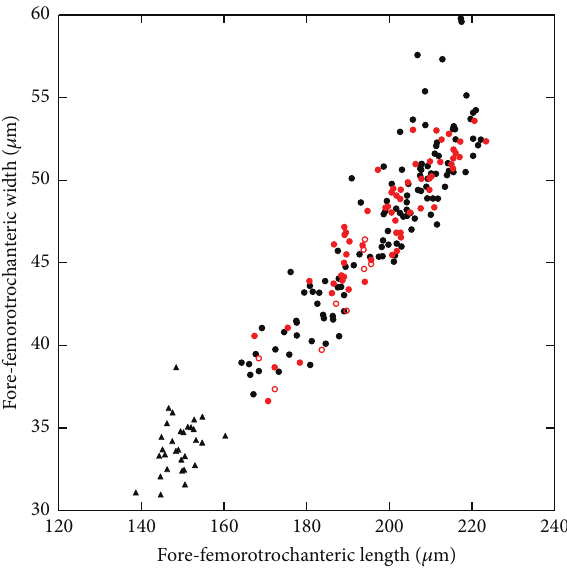
Figure 6: Scattered diagram of the length and width of one fore- femorotrochanter for 31 first-instar nymphs to be apterae (triangle) and 186 first-instar nymphs to be alates (circle) including 62 that actually attacked the introduced moth larvae (red closed circle) in a colony (Exp#6). First-instar nymphs (to be alates) that had the second-instar cuticle developing inside are indicated by red open